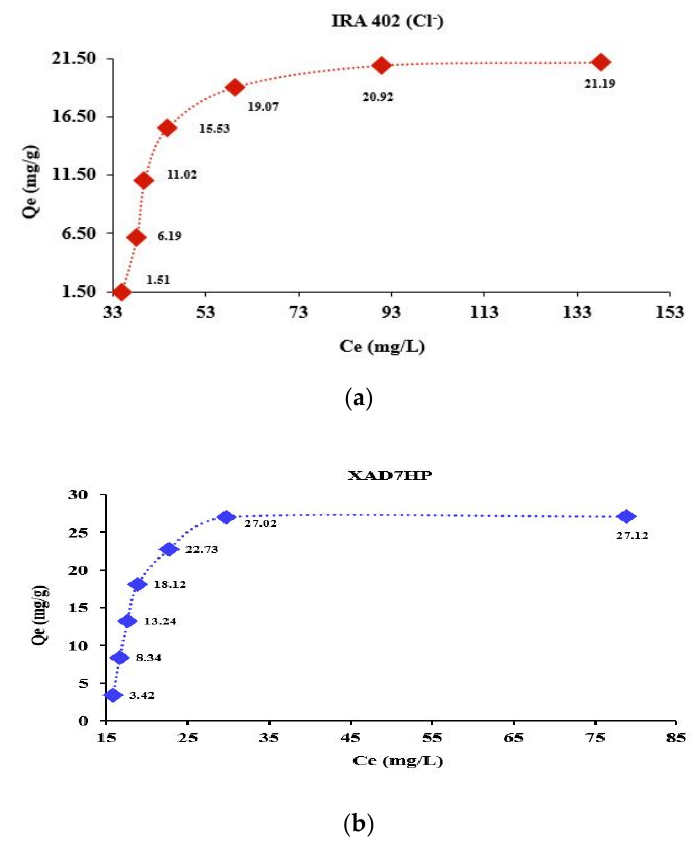
Figure 3. Influence of DR 23 initial concentration for ( a ) IRA 402 (Cl − ) and ( b ) XAD7HP.